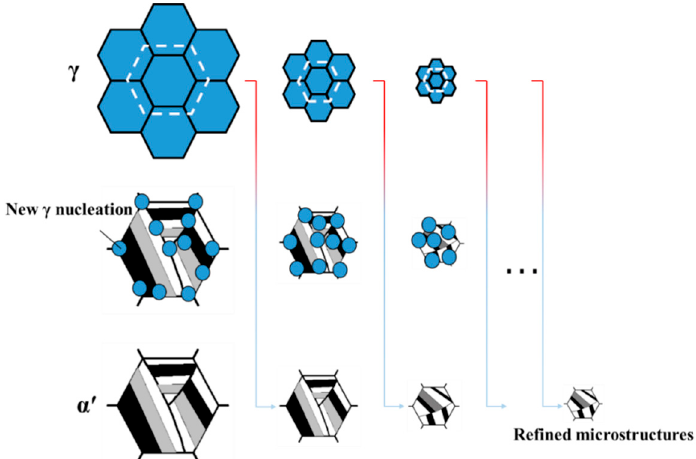
Figure 1. Principles of grain refinement in cyclic phase transformation heat treatment for 65Mn low-alloy steel.